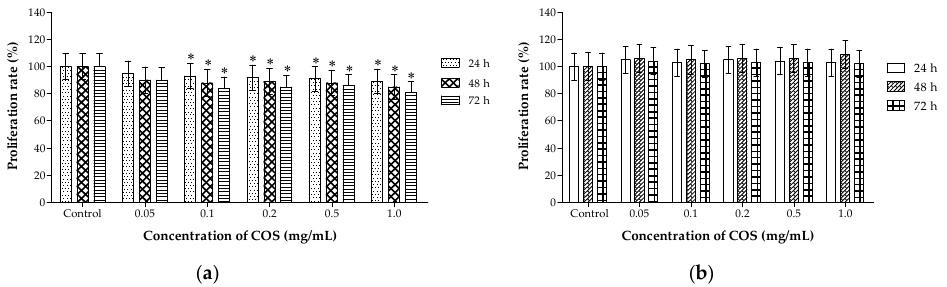
Figure 2. Effects of chitosan oligosaccharides (COS) on the proliferation of A549 and HL-7702 cells. ( a ) Proliferation rate of A549 cells measured by 3-(4,5-dimethylthiazol-2-yl)-2,5-diphenyl tetrazolium bromide (MTT) test. ( b ) Proliferation rate of HL-7702 cells measured by MTT test. Data represents mean ± SD, n = 6, * p < 0.05 significant difference compared with control